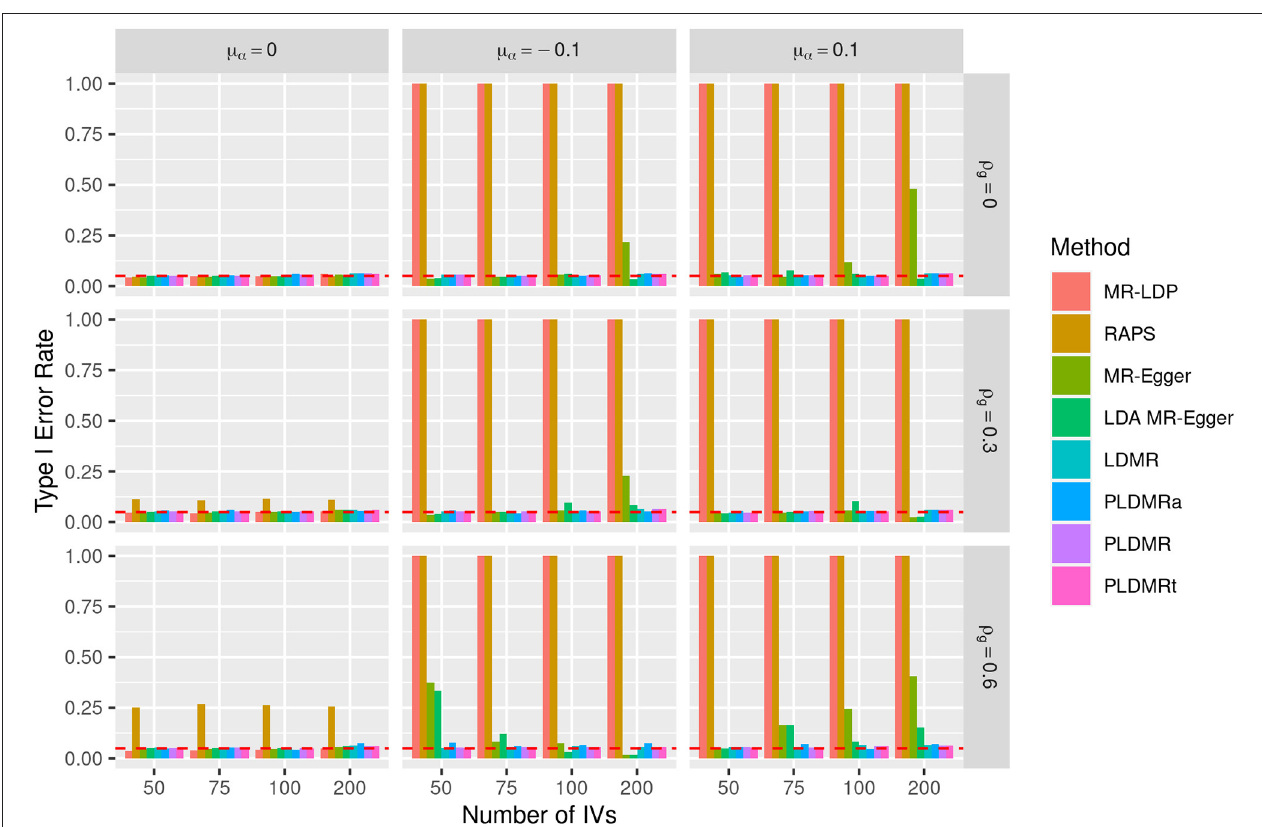
FIGURE 3 | Bar plot of the type I error rates of all methods under the null hypothesis of H 0 : β = 0. Sample size is n = 5,000, σ α = 0.01, and the number of genetic variants m = 50,75,100,200. µ α = 0, − 0.1,0.1 represents the mean of pleiotropic effect and ρ g = 0,0.3,0.6 stands for the relative strength of LD between the genetic variants. The red dashed horizontal line indicates the nominal significance of